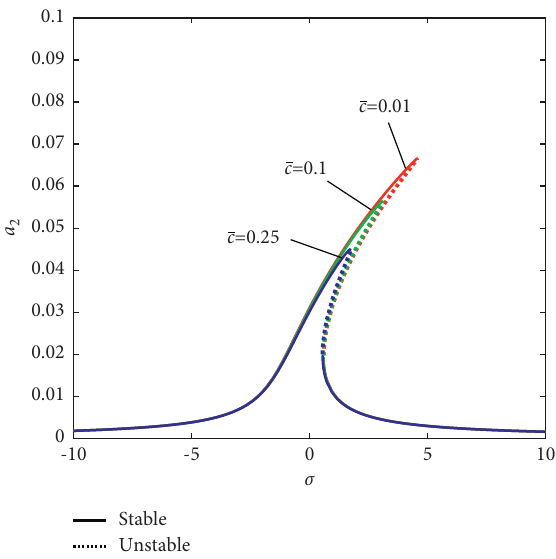
Figure 29: The effect of structural damping on frequency response curve (L/d � 10, θ � 0 ° , case II).